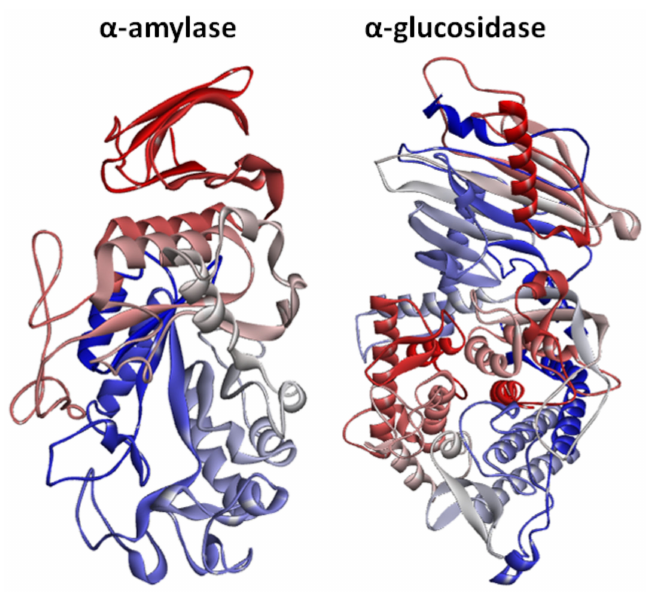
Figure 4. The crystal structures of α -amylase and α -glucosidase.